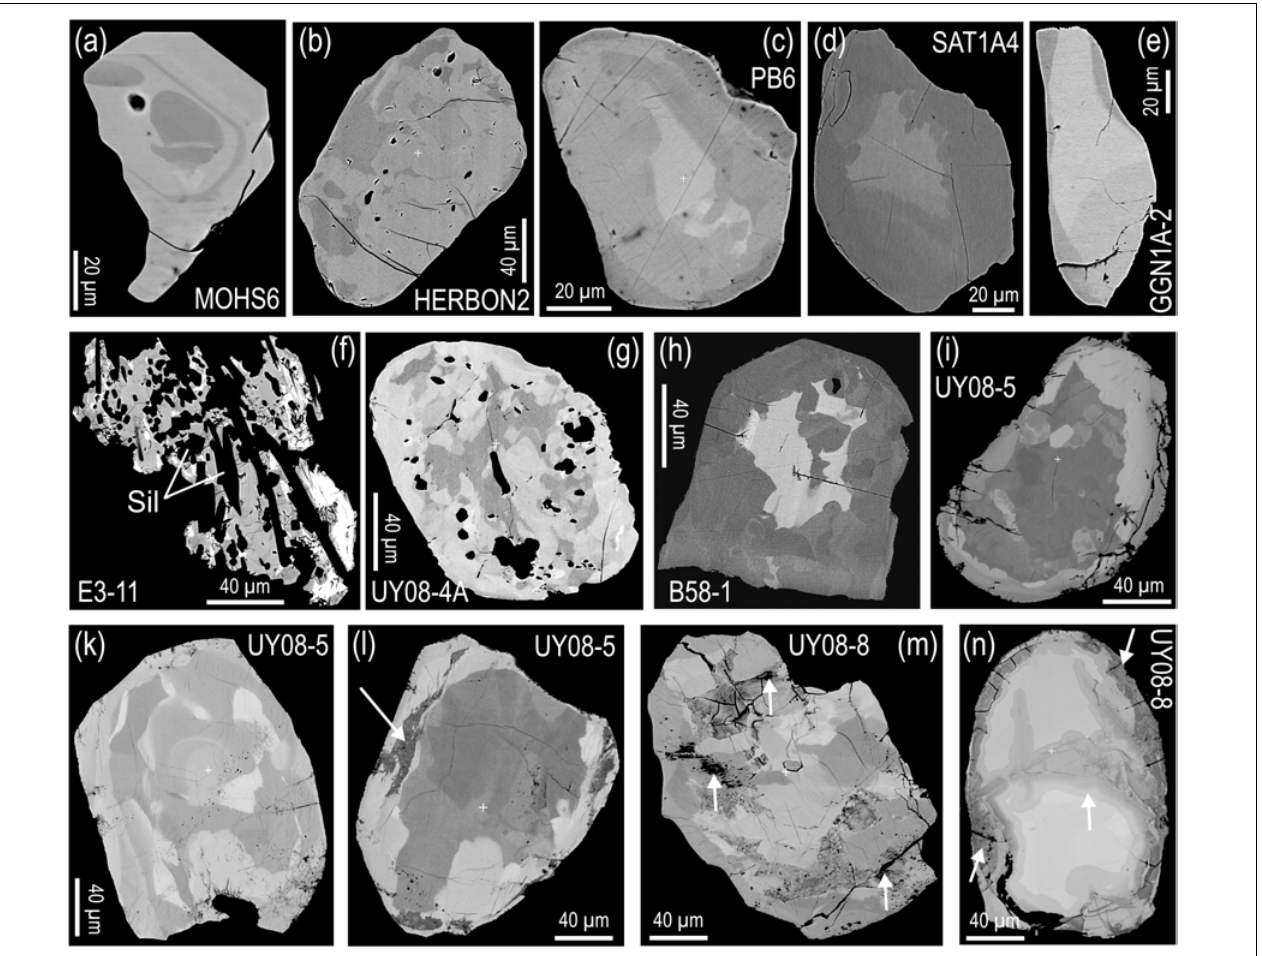
FIGURE 3 | Monazite in high-grade garnet gneiss and migmatite. (a) Weakly zoned and partly euhedral monazite in cordierite garnet gneiss (“kinzigite”) from the Saxonian Granulite Massif. (b) Euhedral monazite with cloudy internal domains and rounded corners from cordierite garnet gneiss (Schulz, 2013). (c) Monazite with rounded corners from a garnet gneiss in the Wilson Terrane, Antarctica (Schulz and Schüssler, 2013). (d,e) Poorly zoned monazite in UHP garnet gneiss (“saidenbachite”) from the Central Erzgebirge (Tichomirowa et al., 2018). (f) Monazite with numerous inclusions of decussate prismatic sillimanite in cordierite garnet gneiss (Saxonian Granulite Massif). (g) Monazite with bright margin and cloudy internal domains from Isla Cristalina de Rivera, Uruguay (Oyhantçabal et al., 2012). (h) Monazite with dark Th-poor margin from a diatexite in the Wilson Terrane. (i-n) Monazites with lobate marginal zones, alteration zones and increasing grade of alteration (arrows) in a grain mount from Isla Cristalina de Rivera, Uruguay.